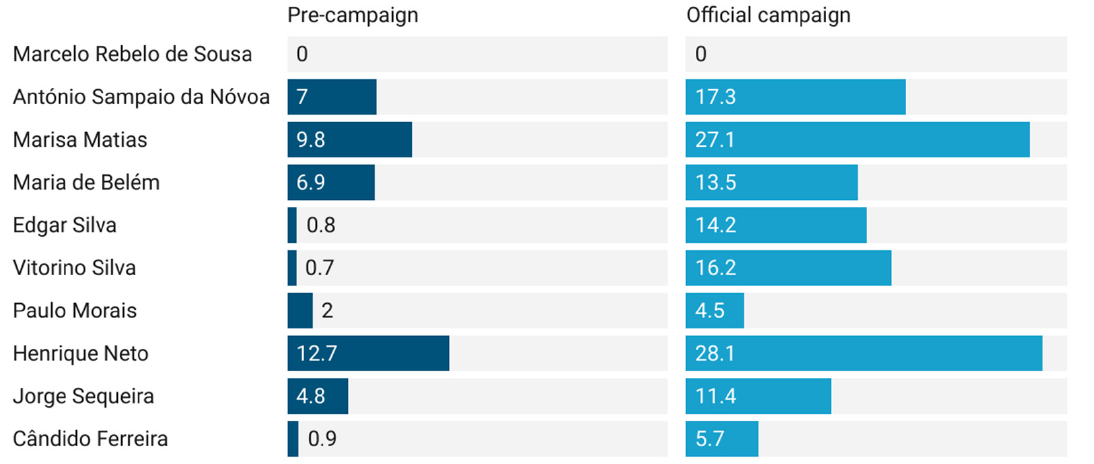
Figure A3. Online campaigning before and after the beginning of the official election campaign in 2016 (average number of daily posts on social media). Source: Own data (see Section 3.1.2).